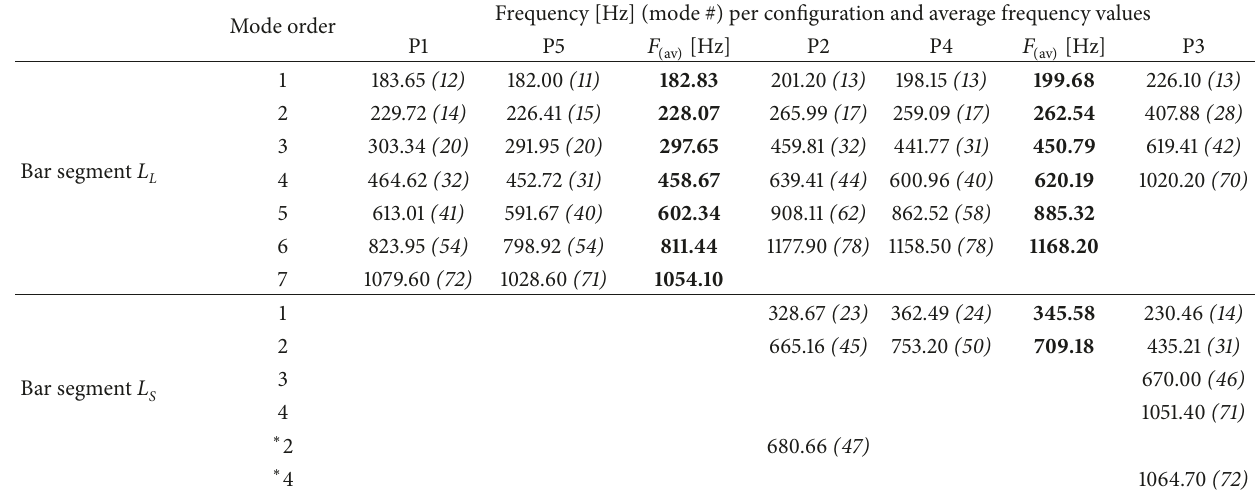
Table 2: Vibration modes at top longitudinal bars with transversal wave